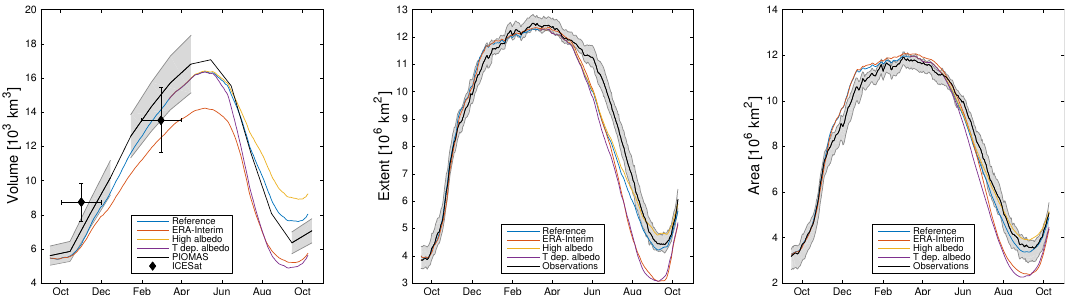
Figure 14. Modelled seasonal cycle in volume (left panel), extent (centre panel), and area (right panel). The volume is calculated within the area covered by the ICESat observations (1) and can be compared to the ICESat and PIOMAS results. The extent and area are calculated within the model grid and can be compared to the AMSR-E observations. Error bars and grey shading indicate observational uncertainties (for further details see text).